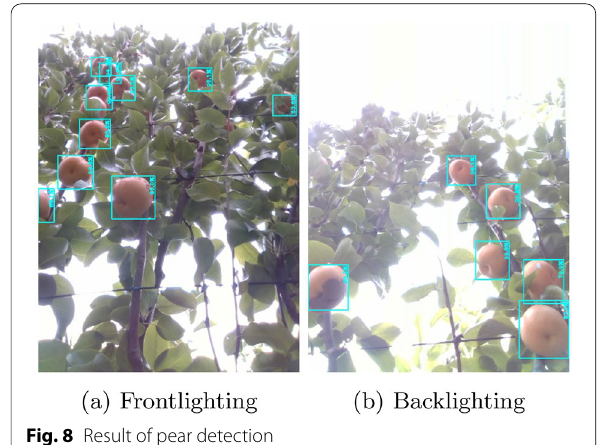
Fig. 8 Result of pear detection